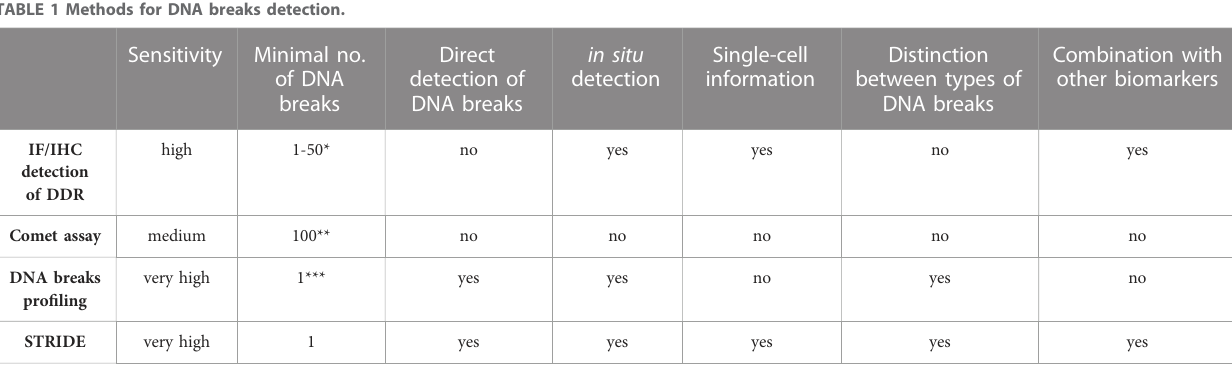
TABLE 1 Methods for DNA breaks